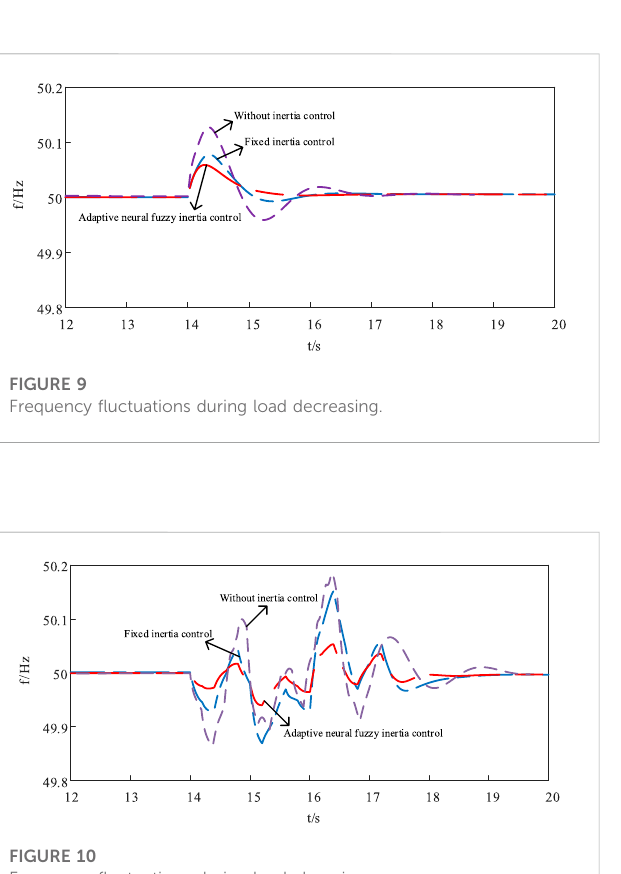
FIGURE 10 Frequency fl uctuations during load changing.